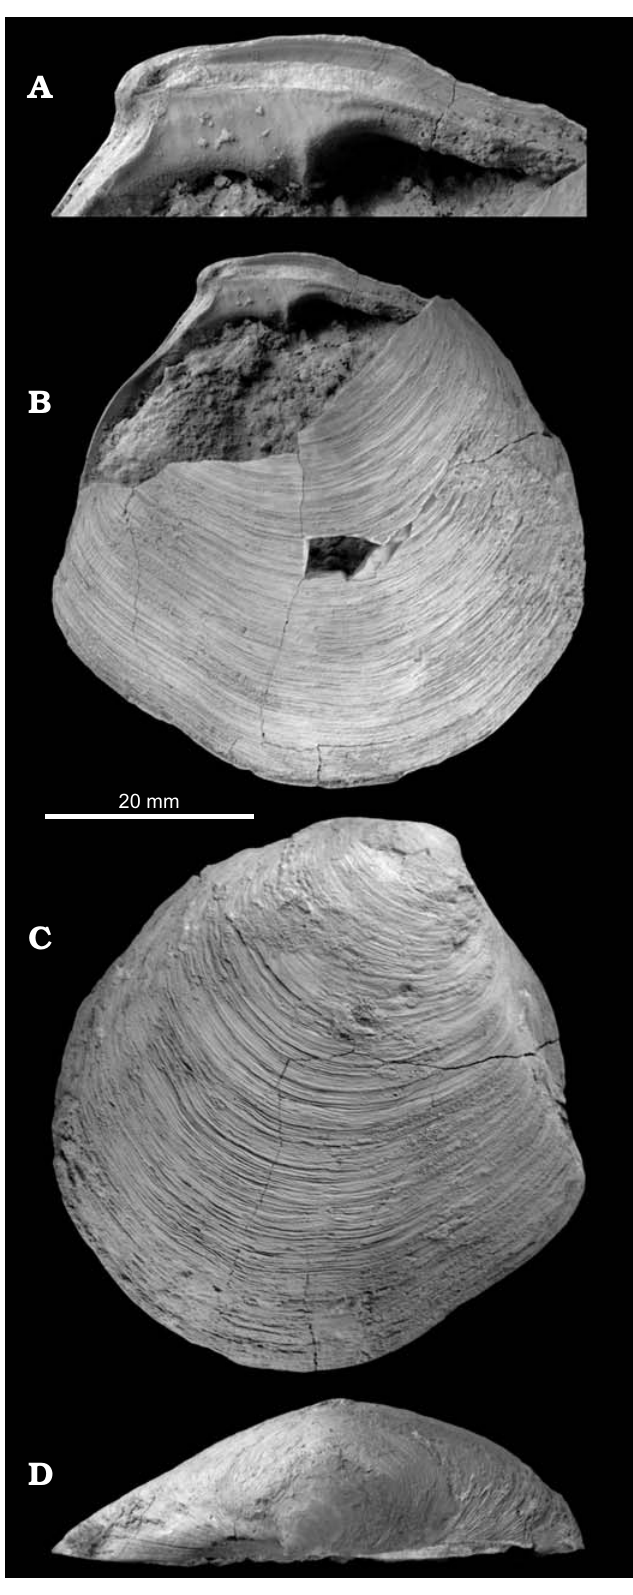
Fig. 3. The lucinid bivalve Megaxinus ellipticus (Borson, 1825) from the late Pliocene of Italy, Stirone River seep deposit. MGGC.22008, close-up of hinge region of RV ( A ), view of left valve exterior and right valve hinge ( B ), view of exterior of right valve ( C ); dorsal view on right valve ( D